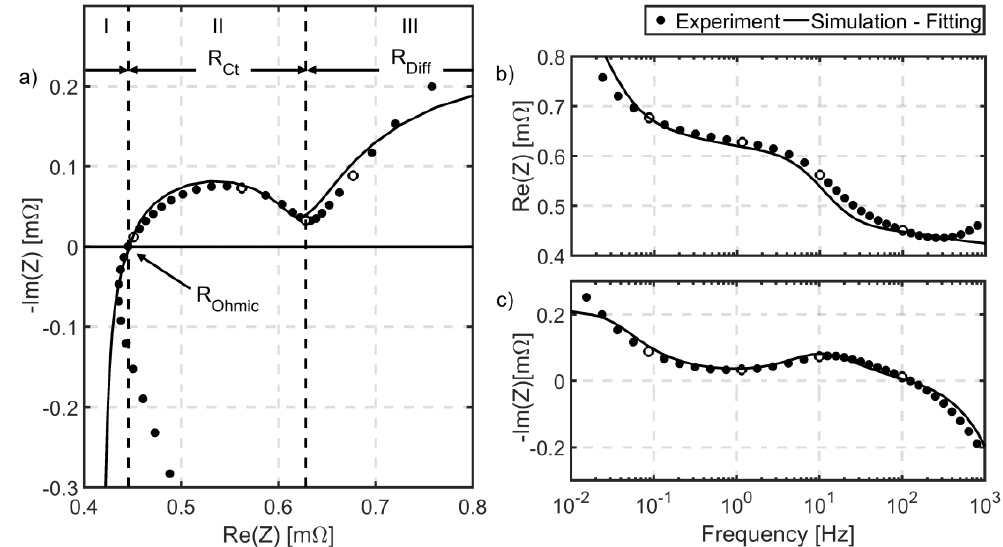
Figure 4. Experimental vs. fitting results of the cell impedance model: ( a ) Nyquist plot ( b ) Contribution of real impedance (mΩ) and ( c ) negative imaginary impedance (mΩ) as function of frequency (Hz).